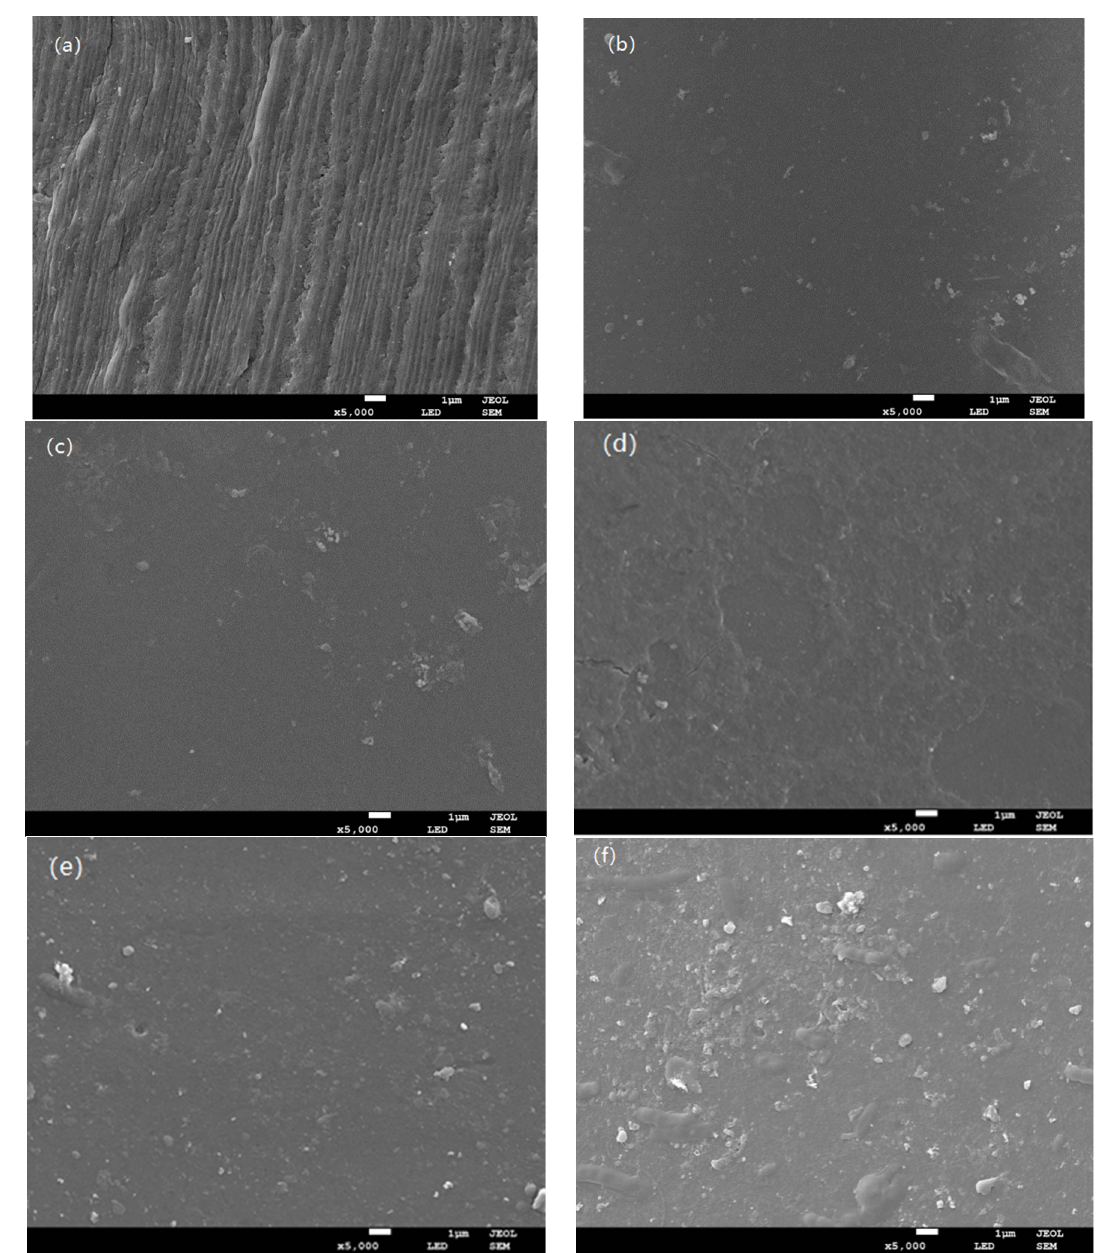
Figure 5. The SEM image of the surface of the membrane: ( a ) new membrane, ( b ) membrane surface with square wave function feeding, ( c ) membrane surface with sinusoidal function feeding, ( d ) membrane surface with reciprocal function feeding, ( e ) membrane surface with power function feeding, and ( f ) membrane surface with steady flow feeding.